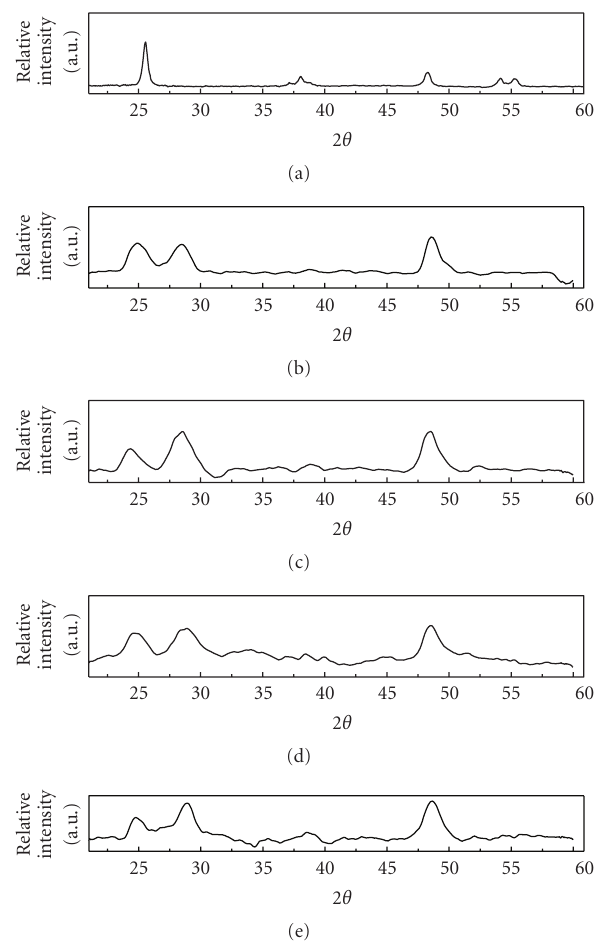
Figure 2: XRD patterns of: (a) Pure TiO 2 ; (b) pure TNT, and (c) 2% Gd 3+ -TNT; (d) 5% Gd 3+ -TNT; (e) and 7% Gd 3+ -TNT.